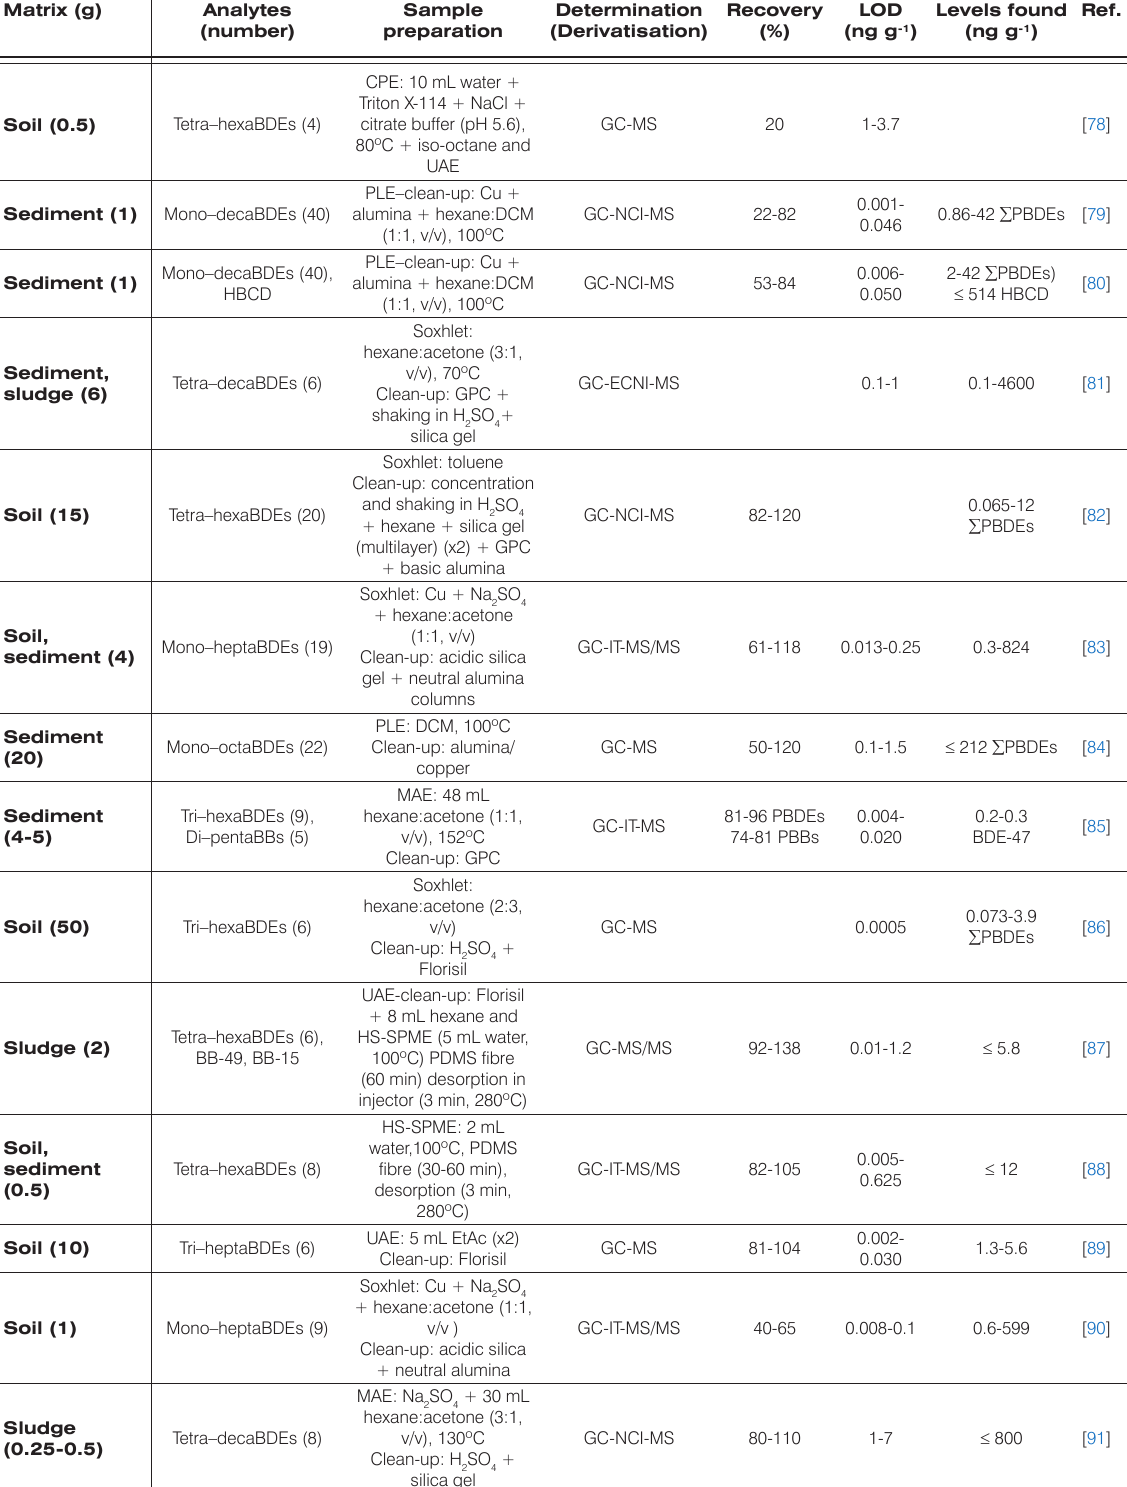
Table 3. Analysis of PBDEs and PBBs in environmental solid